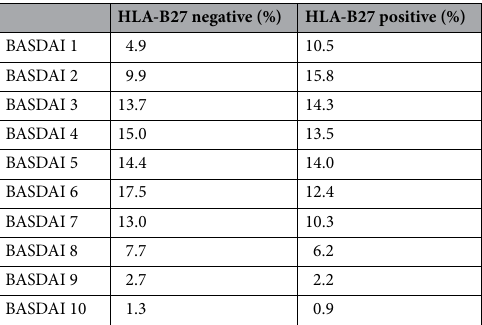
Table 1. BASDAI score Relative to HLA-B27 status. This table shows the proportions of subjects with each BASDAI score with subjects analyzed by HLA-B27 status. The difference in BASDAI relative to B27 status is highly significant by Pearson’s chi-squared test, p <